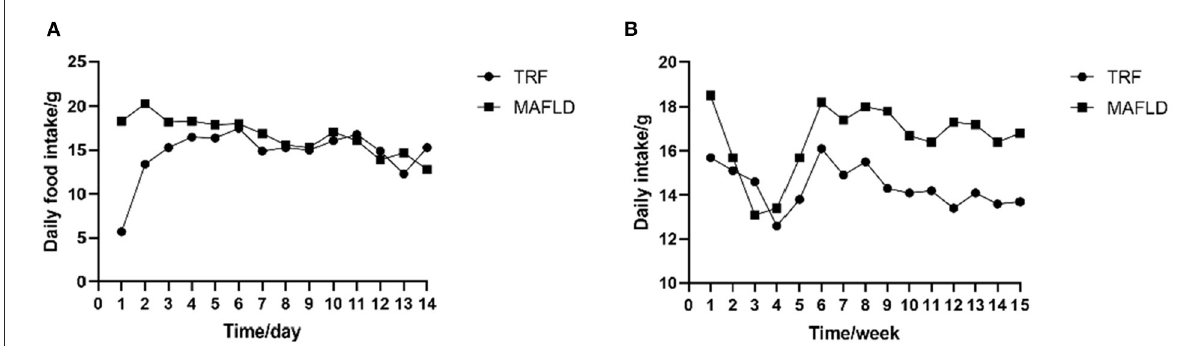
FIGURE2 Feeding behavior. (A) Daily food intake of each rat from day 1 to 14; (B) average daily food intake of each rat from 1 to 15 weeks (g). MAFLD (metabolic associated fatty liver disease), rat fed a high-fat diet ad libitum ; TRF (time-restricted feeding), fed high-fat diet (60 kcal% fat) strictly only between 16:00 and 22:00 every day.